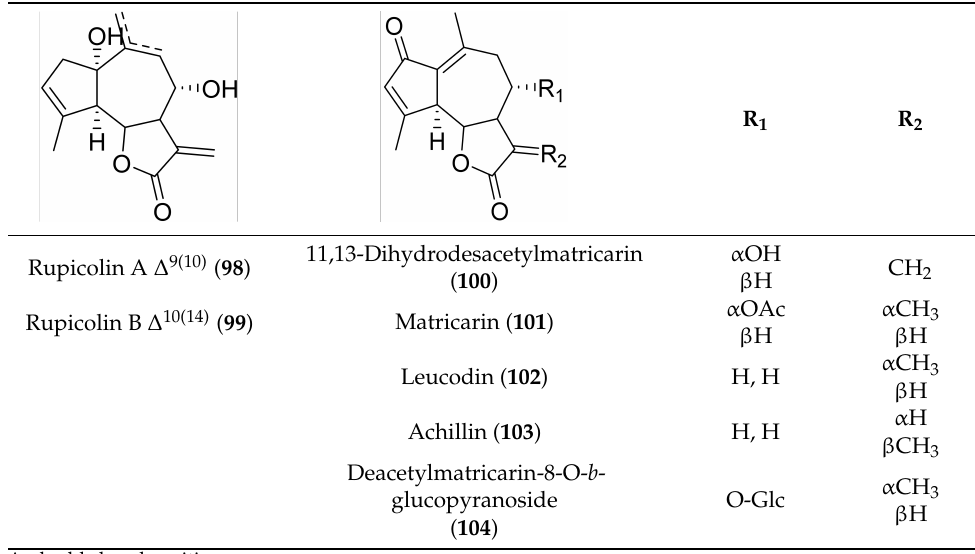
Table 8. Chemical structures of Guaianolides from Achillea spp. Part